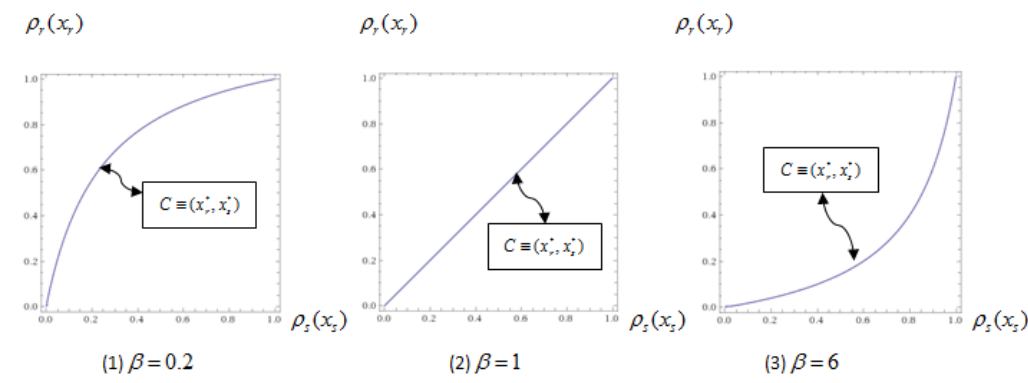
Figure 2. Pure-strategy Nash equilibrium for all value of majority rule M